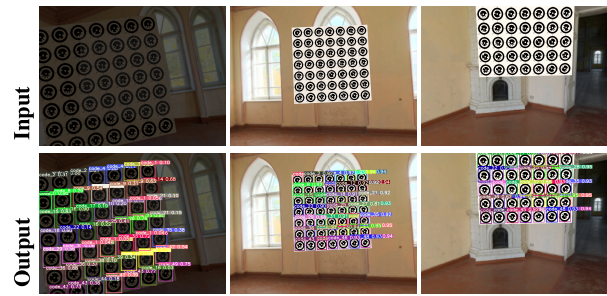
Figure 5. Examples from the dataset.